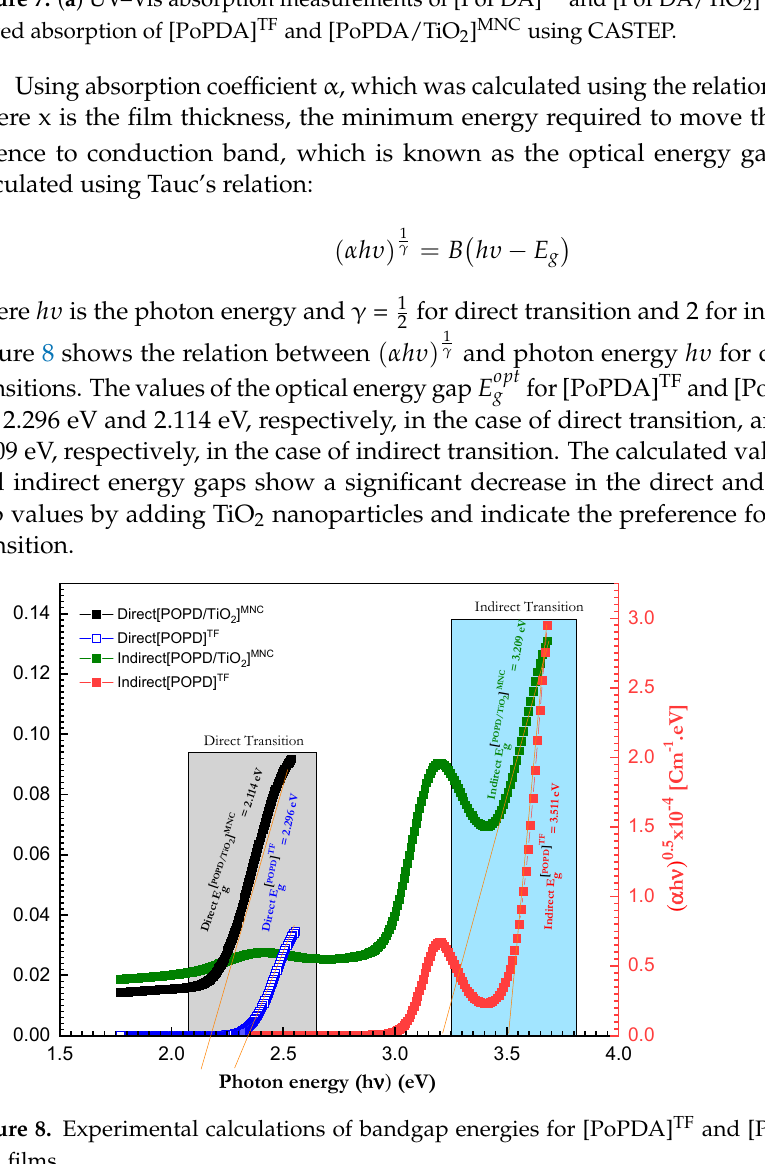
Figure 8. Experimental calculations of bandgap energies for [PoPDA] TF and [PoPDA/TiO 2 ] MNC thin